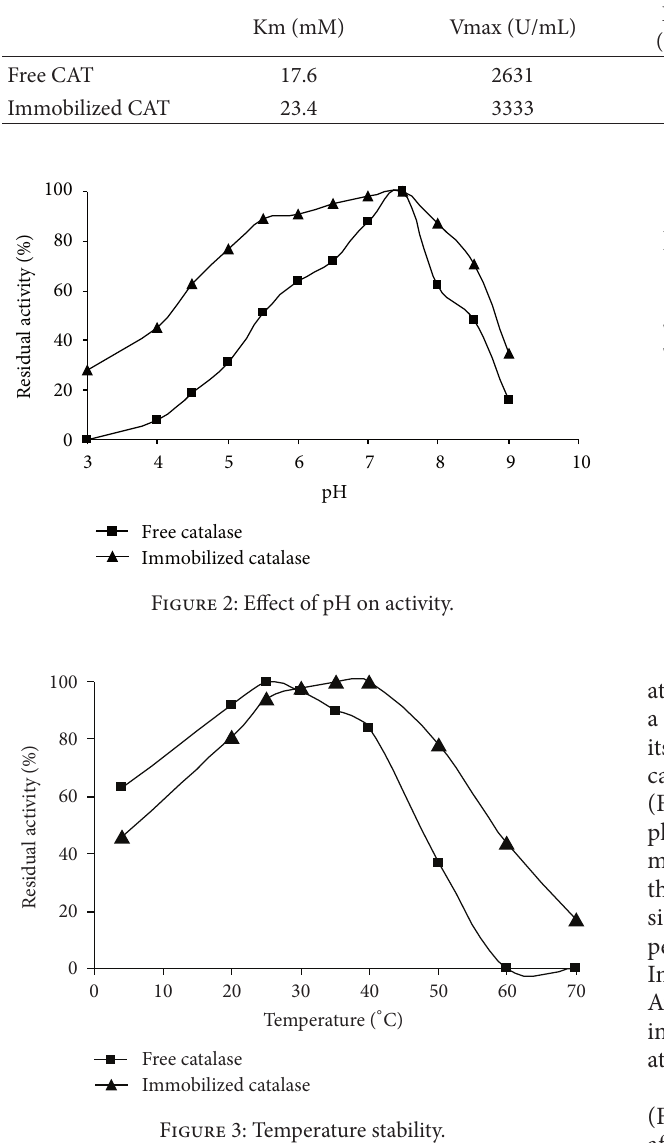
F 3: Temperature stability.